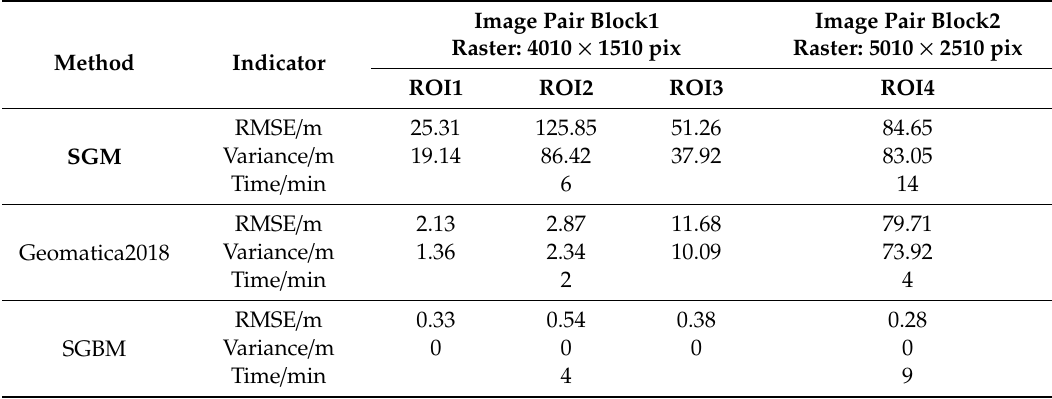
Table 3. Quantitative